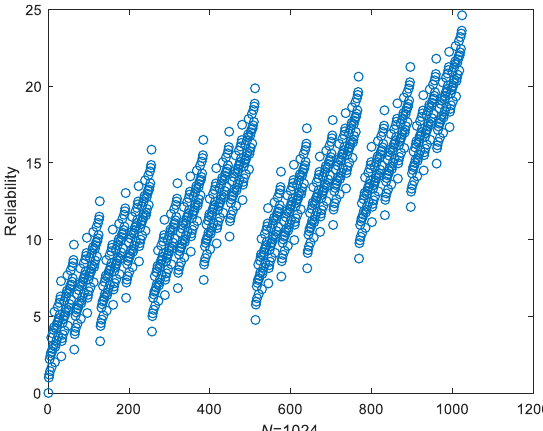
Figure 6. Reliability of each sub-channel when N = 1024.